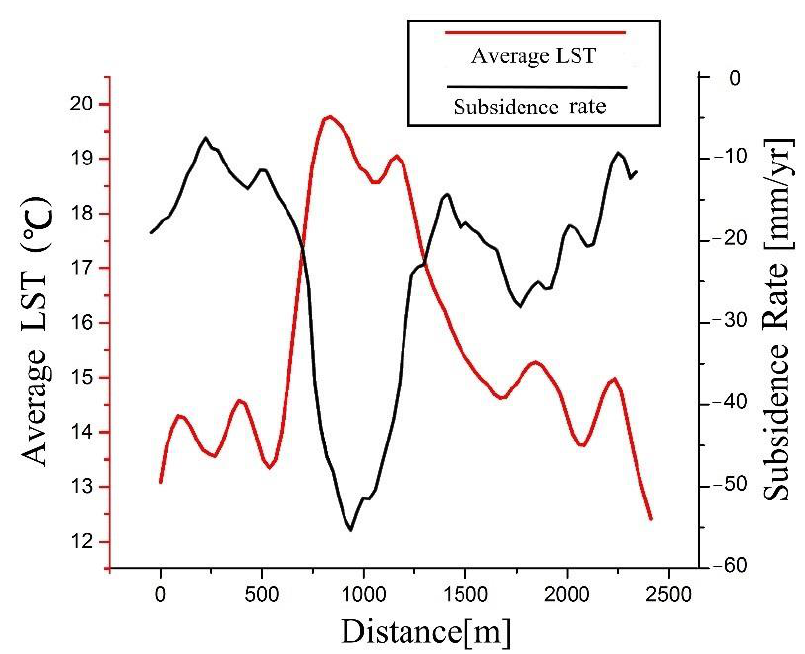
Figure 13. Profile analysis of average land surface temperature (LST) and subsidence rate in coal fire areas.